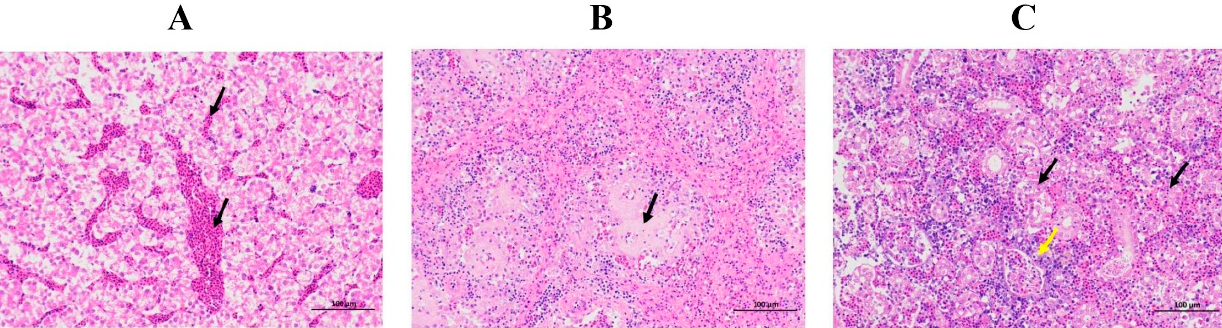
Figure 2. Histopathological observation and analysis by HE. Liver ( A ): A small area of central vein